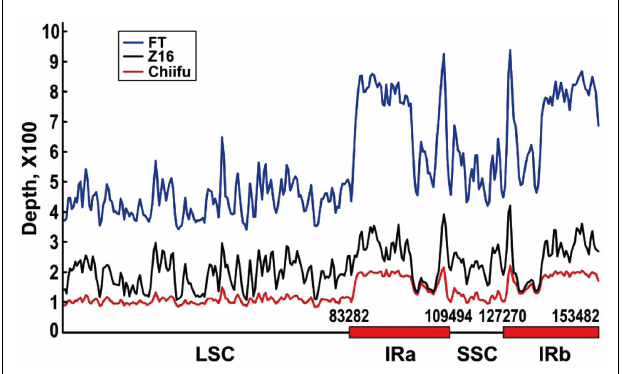
FIGURE 2 | Plot showing sequencing depth by position for chloroplast genomes of three B. rapa accessions sequenced by Solexa Genome Analyzer with whole cellular DNA as template. Number of micro-reads per position ( y -axis) is plotted against position in the assembly ( x -axis, in kb) in a window size of 100bp. Numbers above x -axis indicate boundary sites of large single copy (LSC) and small single copy (SSC), and two inverted repeats (IRa and